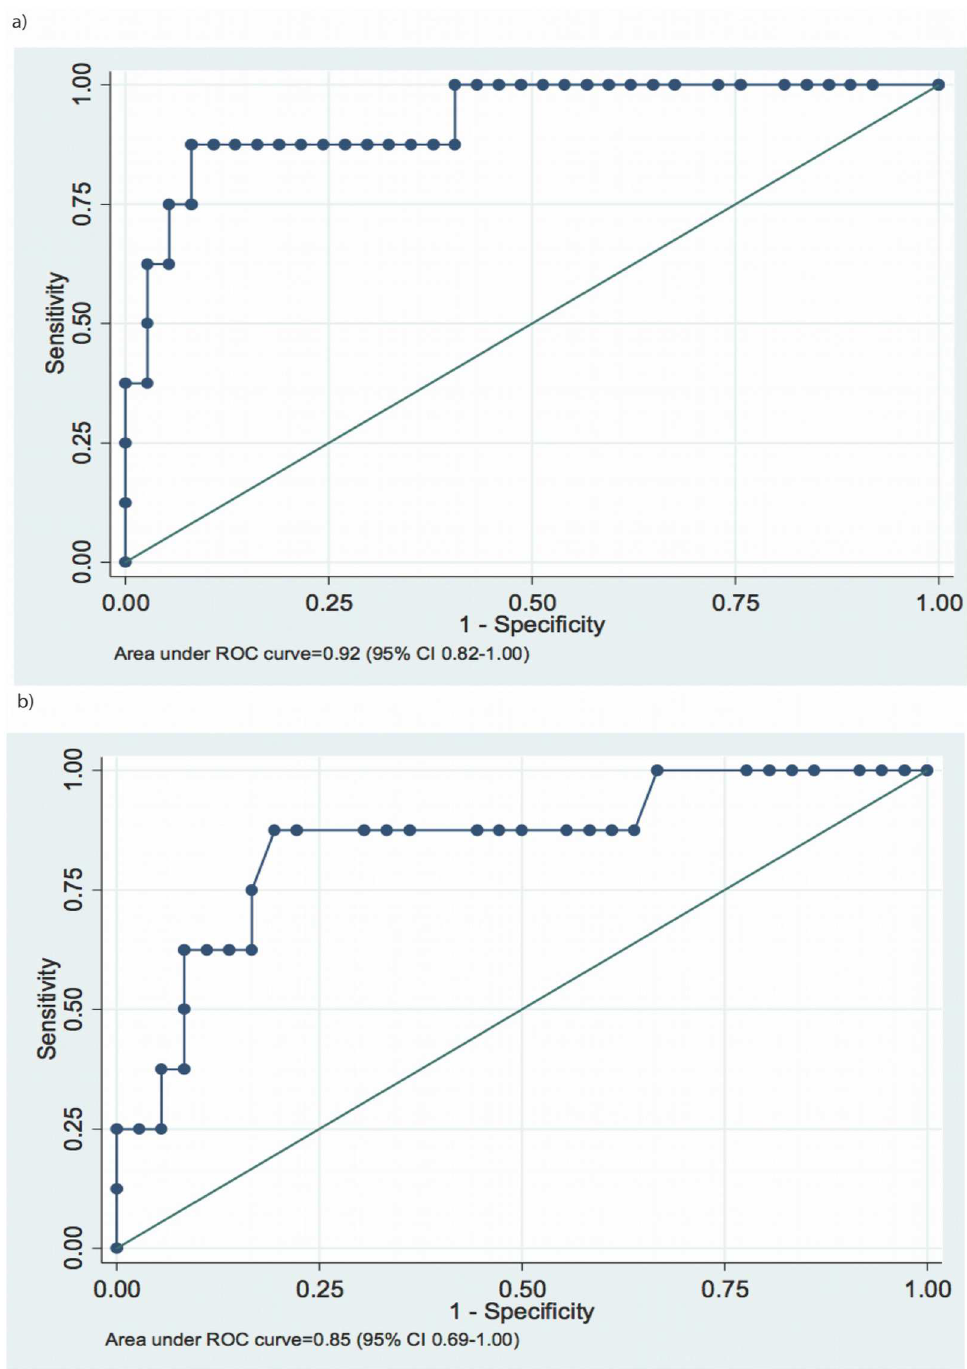
Fig 3. Receiver-operating characteristic curves for a) brain natriuretic (BNP) and b) serum total bilirubin concentration, for separation of patients who died from those who survived during the follow-up period.